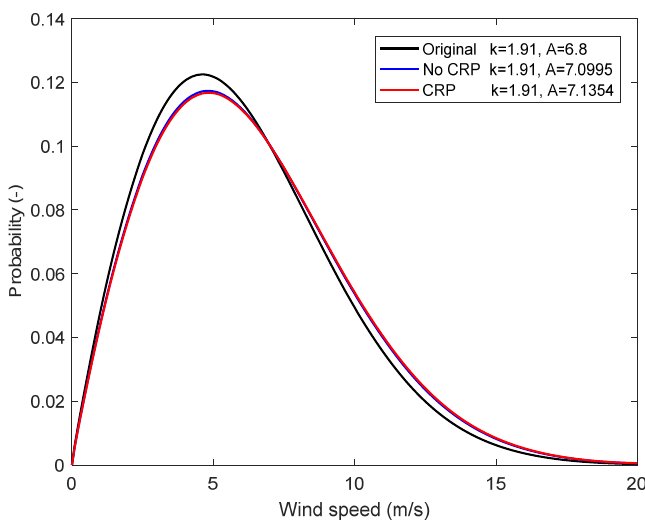
Figure 14. Weibull probability distribution of wind speed (6 m/s, 6.2969 m/s and 6.3288 m/s).